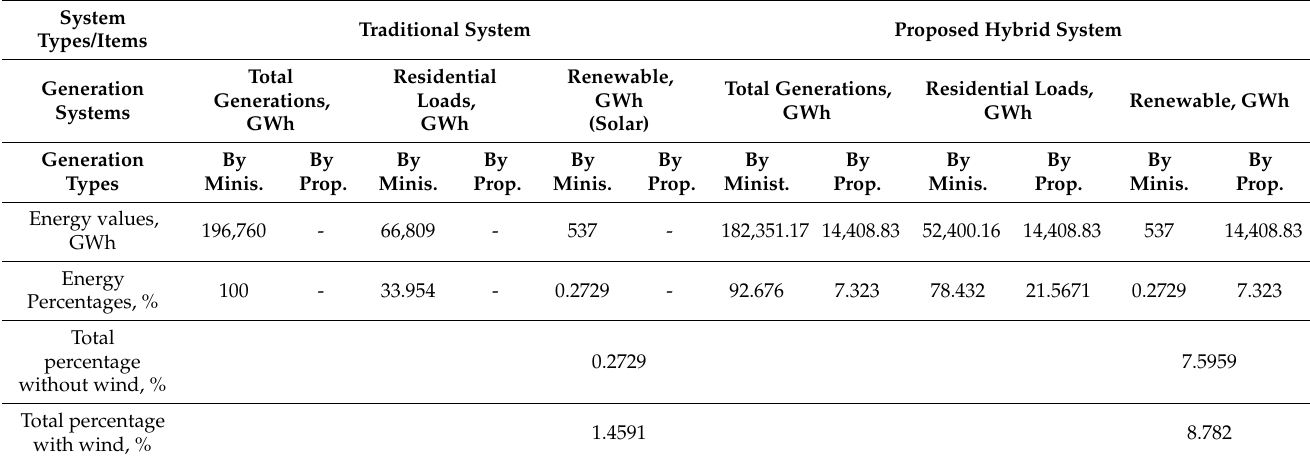
Table 8. Contributions of the proposed hybrid system in various generation/loads